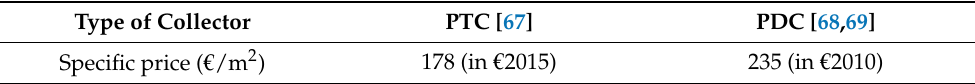
Table 6. Solar panels’ specific costs based on data from